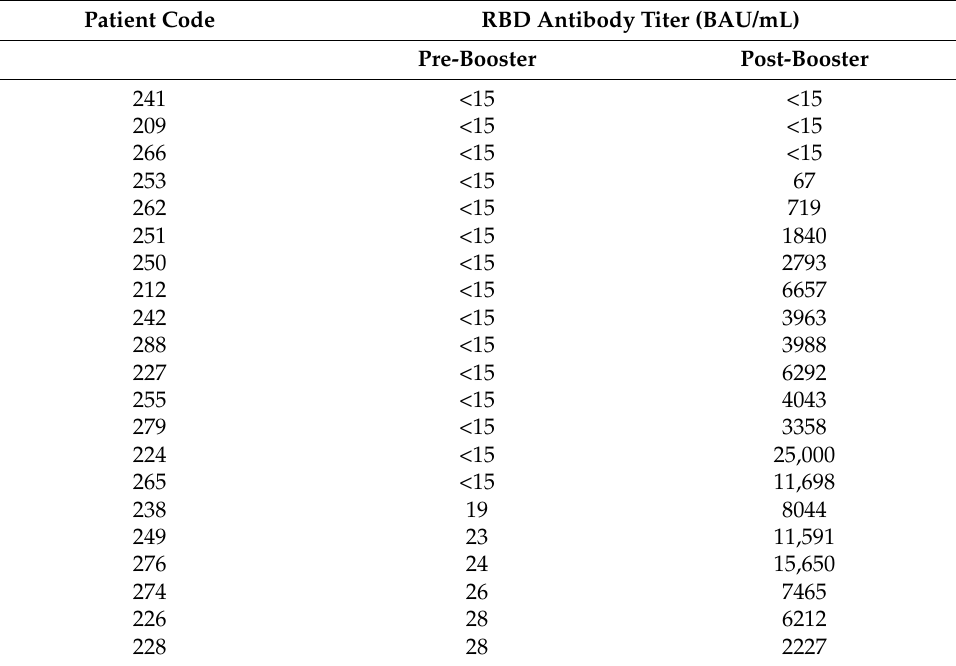
Table 2. SARS-CoV-2 S antibody titers in low/non- responders on the day of and 4 weeks after the booster shot.